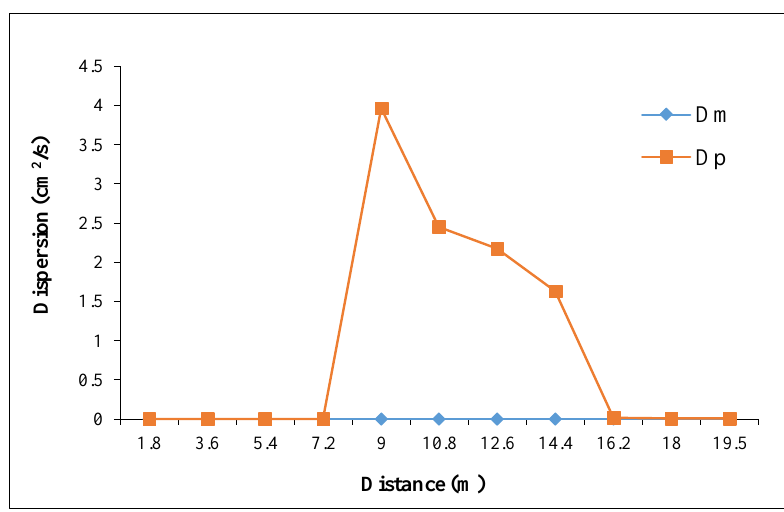
Figure 3. Verification curve for Shao et al. [8] model.